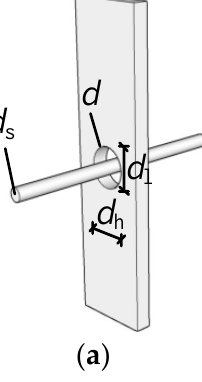
Figure 4. Diagrams of the perfobond ribs: ( a ) Perfobond rib with single hole; ( b ) Perfobond rib with two holes; ( c ) Perfobond rib with long-holes; ( d ) Perfobond rib with high-holes. Lubricating oil was applied to the contact surface between the steel and concrete to eliminate the influence of friction therebetween. Moreover, to avoid the concrete end- bearing effect below the perfobond rib a 100 × 70 × 16 mm slot was retained at the bottom of the perfobond rib, to leave space for the styrofoam.